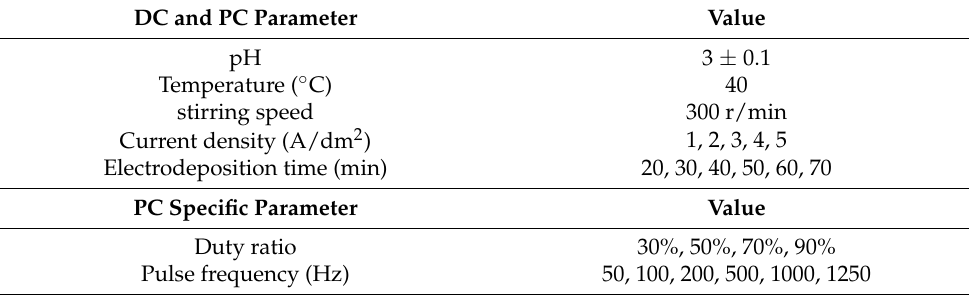
Figure 1. Schematic diagram of direct current waveform ( a ) and pulse current waveform ( b ). The current density (3 A/dm 2 ), pulse period (1 ms), and duty cycle ratio (70%) were the best values for the experimentally obtained parameters. Table 2. Parameters of the electrodeposition